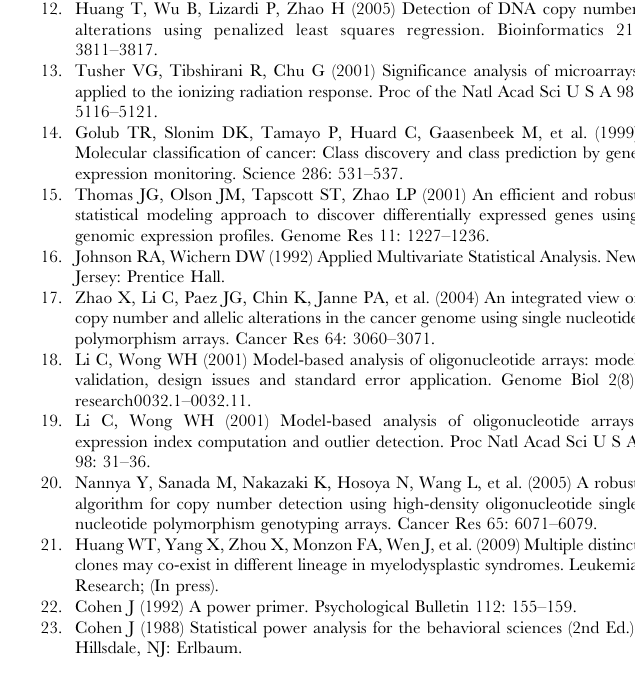
Table S2 Copy number aberrations comparison of CMA algorithm and CNAG (MDS-7 is excluded). The cutoff value of copy number one and three in CNAG is 2 0.35 and 0.35, and the window size of moving average is 5 (chromosomes with only single altered SNP excluded). Two-group t-test are performed under the null hypothesis that the means of two groups are no significant different.